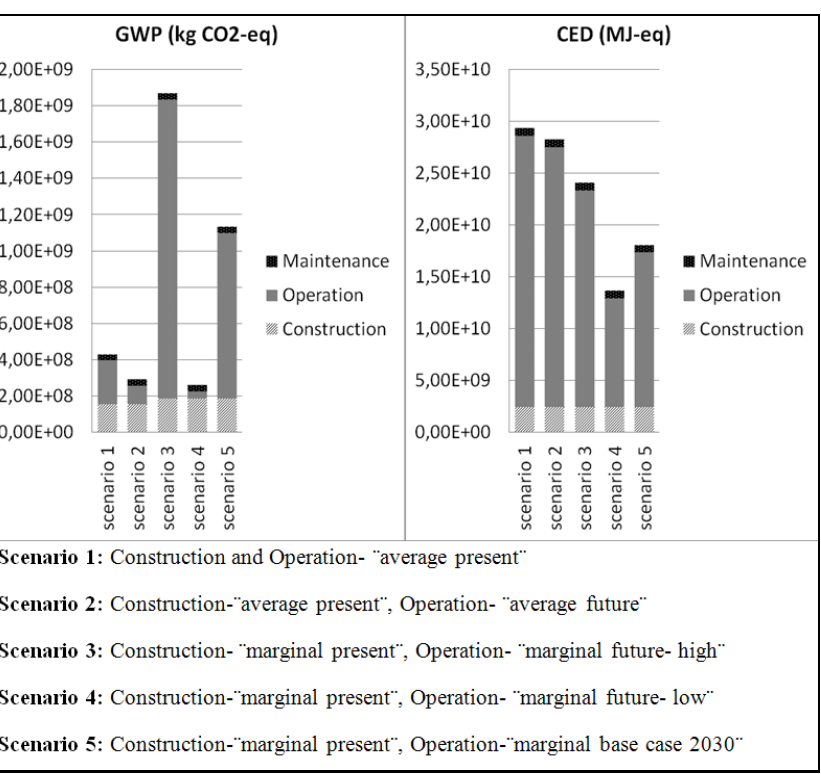
Figure 5. Sensitivity analysis for the choice of electricity mix Data regarding the CED and GWP for the types of electricity considered in Scenarios 1-5 were calculated with the help of SimaPro (see in Table